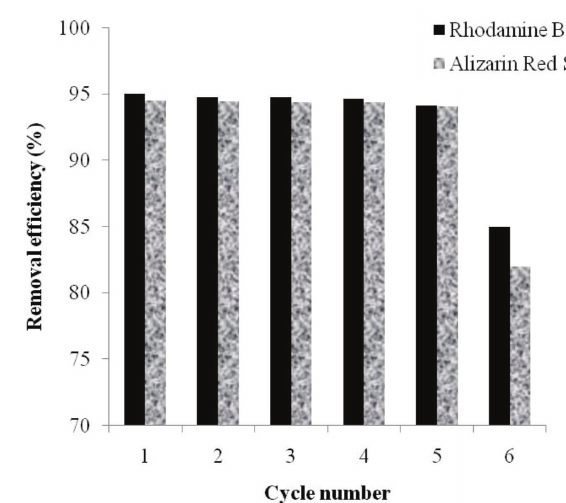
Fig. 14 – Effect of number of cycle runs for the reusability of CES adsorbent